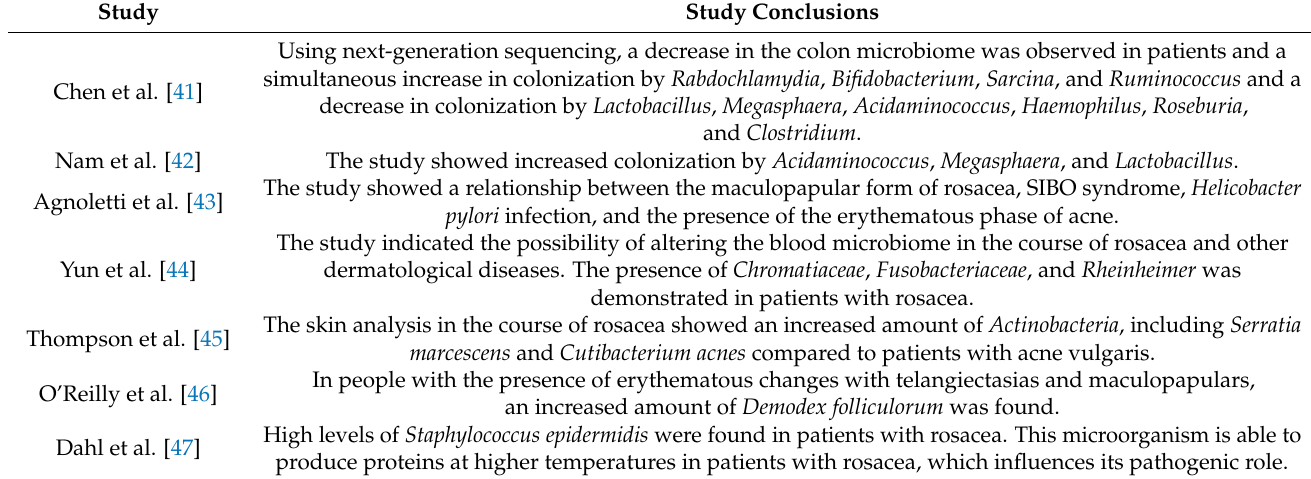
Table 1. Selected studies on the composition of microflora in people with